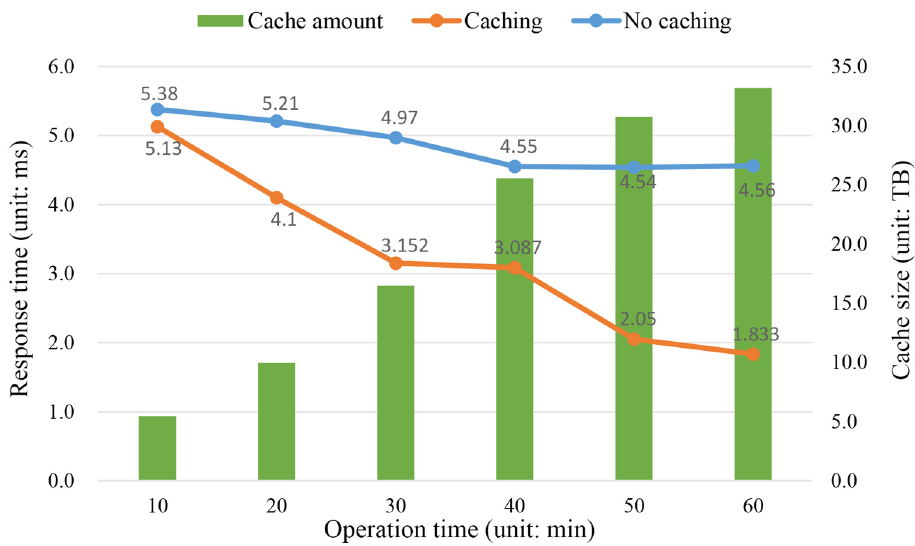
Figure 13. Comparison of the concurrent response efficiency with and without caching.